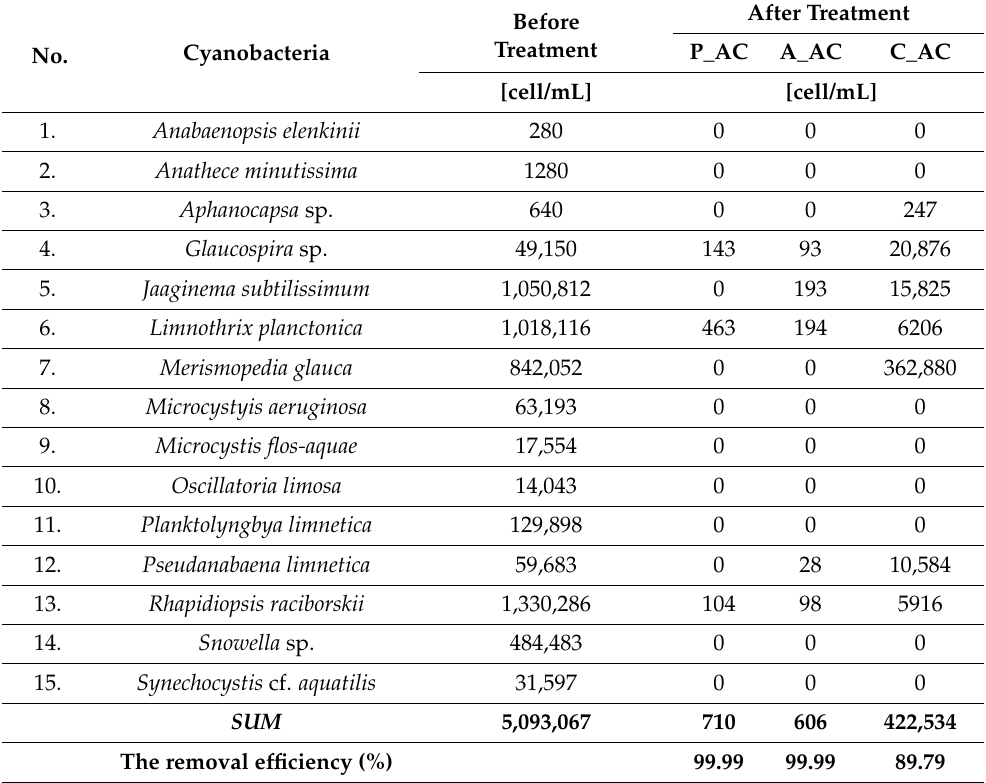
Table 6. Cyanobacteria analyses from Aleksandrovac Lake in August 2021 and removal efficiency of activated carbons.